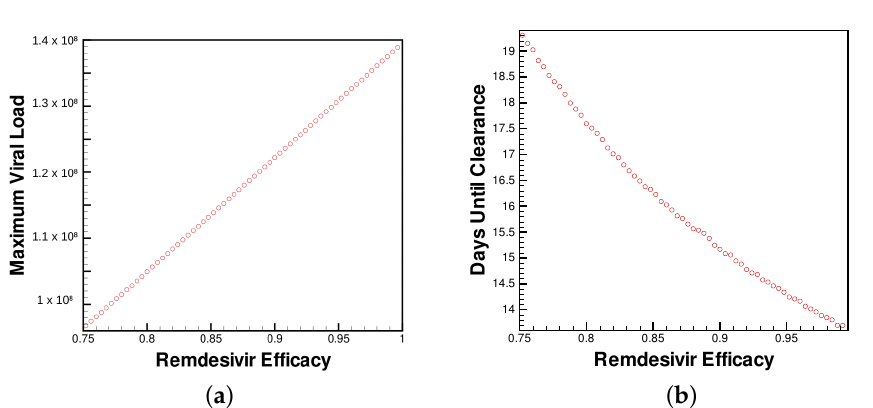
Figure 3. ( a ) Maximum viral load and ( b ) time until viral clearance observed by patients for varying levels of Remdesivir treatment.